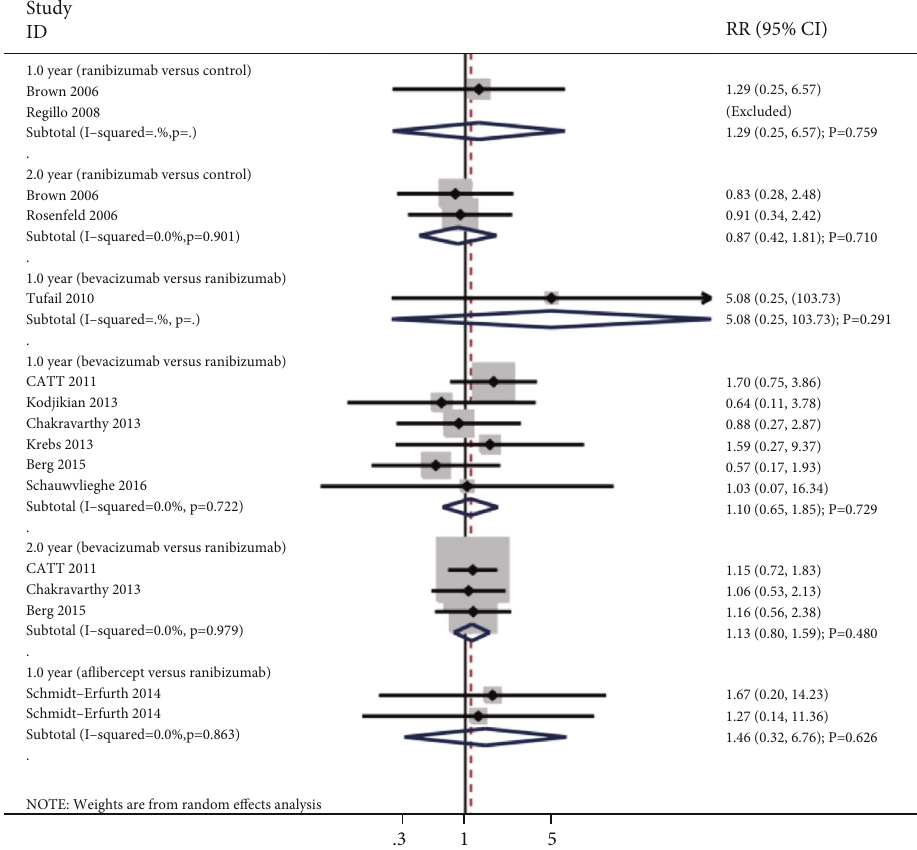
Figure 5: E ff ect of anti-VEGF inhibitors on the risk of